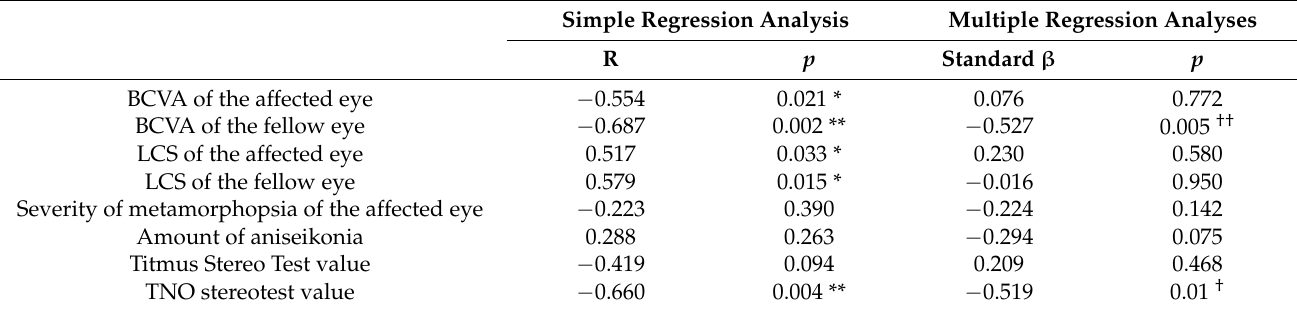
Table 4. Visual functions affecting VFQ-25 composite score 12 months after treatment.